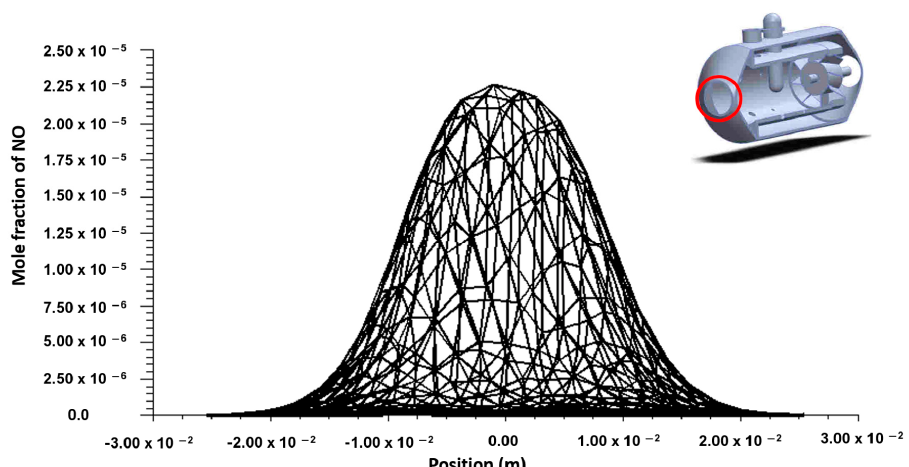
Figure 14. Mole fraction profiles of NO for transverse planes: ( a ) plane 1; ( b ) plane 2; ( c ) plane 3; ( d ) plane 4; ( e ) plane 5; ( f ) plane 6.